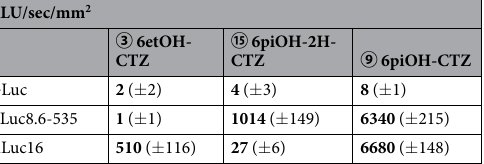
Table 1. The absolute optical intensities of the selected CTZ analogues according to luciferases (n = 3). The optical intensities (RLU) as primary data were divided by integration time (sec) and area (mm 2 ). Therefore, the unit is RLU/sec/mm 2 . The standard deviation ( ± s.d.) was specified in parenthesis.